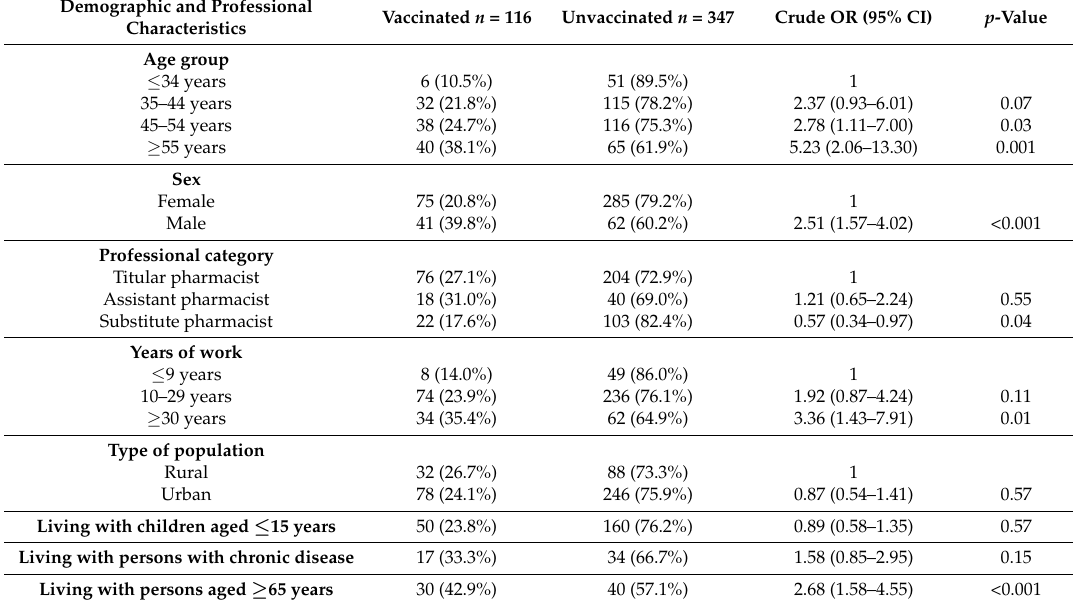
Table 1. Distribution of influenza vaccinated and unvaccinated community pharmacists in the 2013– 2014 season by demographic and professional characteristics.